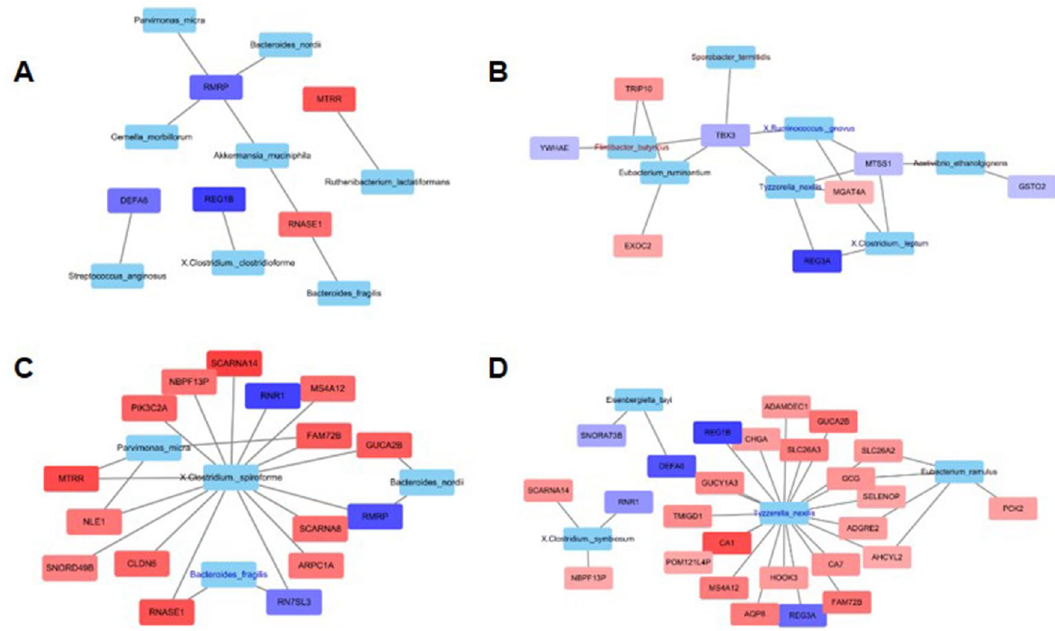
Figure 4. Interaction networks between differentially expressed genes (DEGs) and relative abundance of microbial strains. ( A ) Network analysis of 13 advanced colorectal cancer (ACRC) samples and 10 high-risk adenoma (HRA) samples versus 7 normal control (NC) samples. ( B ) Network analysis of 13 ACRC samples versus 10 HRA samples. ( C ) Network analysis of 13 ACRC samples versus 7 NC samples. ( D ) Network analysis of 10 HRA samples and 7 NC samples. Genes that are enriched in the word group are indicated in red; all other genes are in blue. Species with high relative abundance in the word group are indicated in red; all other species are in